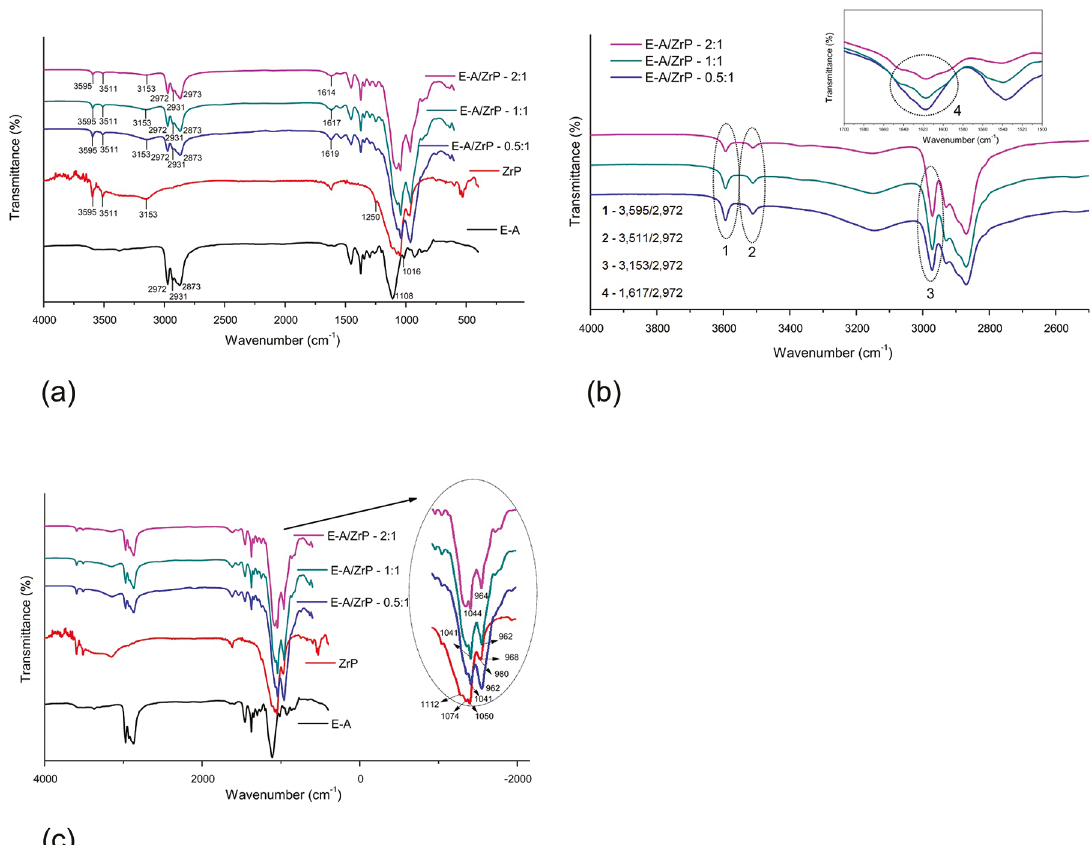
Figure 1. (a) FTIR spectra of the ether-amine oligomer, ZrP and modified ZrP, (b) FTIR spectra of the modified phosphates indicating changes in band shapes, and (c) Highlighted crystal/interlayer water absorption